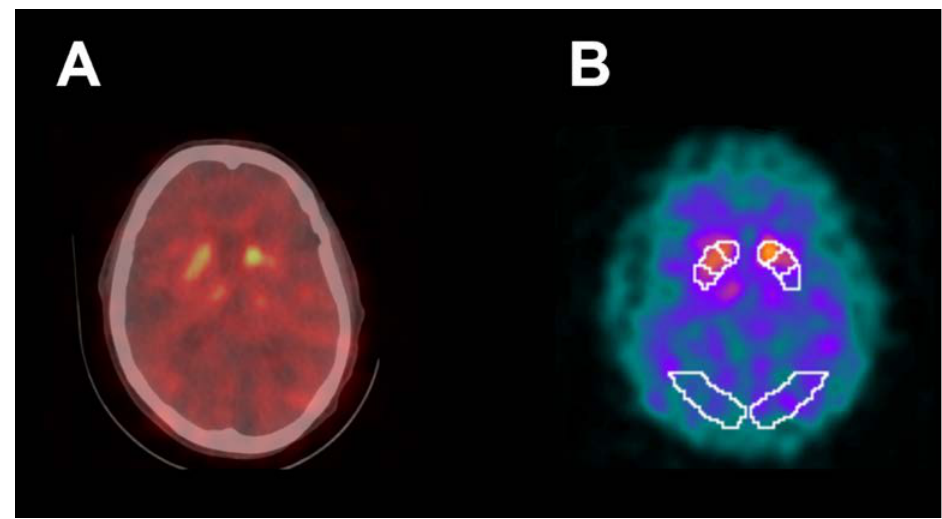
Figure 5. Abnormal [ 123 I]FP-CIT SPECT/CT ( A ) in a 76-year-old right-handed male demonstrating decreased activity in the striatum bilaterally, particularly in the left putamen. [ 123 I]FP-CIT SPECT images ( B ) co-registered to the DaTQUANT software template demonstrated a left putamen SBR of 0.6 with z-score of − 3.93. UPDRS-III motor score was 5 and MoCA score was 20. Patient was not receiving medication for PD. For contralateral right upper extremity, VR time was 50 s, VR ADL Score was 9.8, VR Rest Tremor Power was 1.48 × 10 −8 m 2 /Hz, and VR Posture Tremor Power was 6.09 × 10 −8 m 2 /Hz.